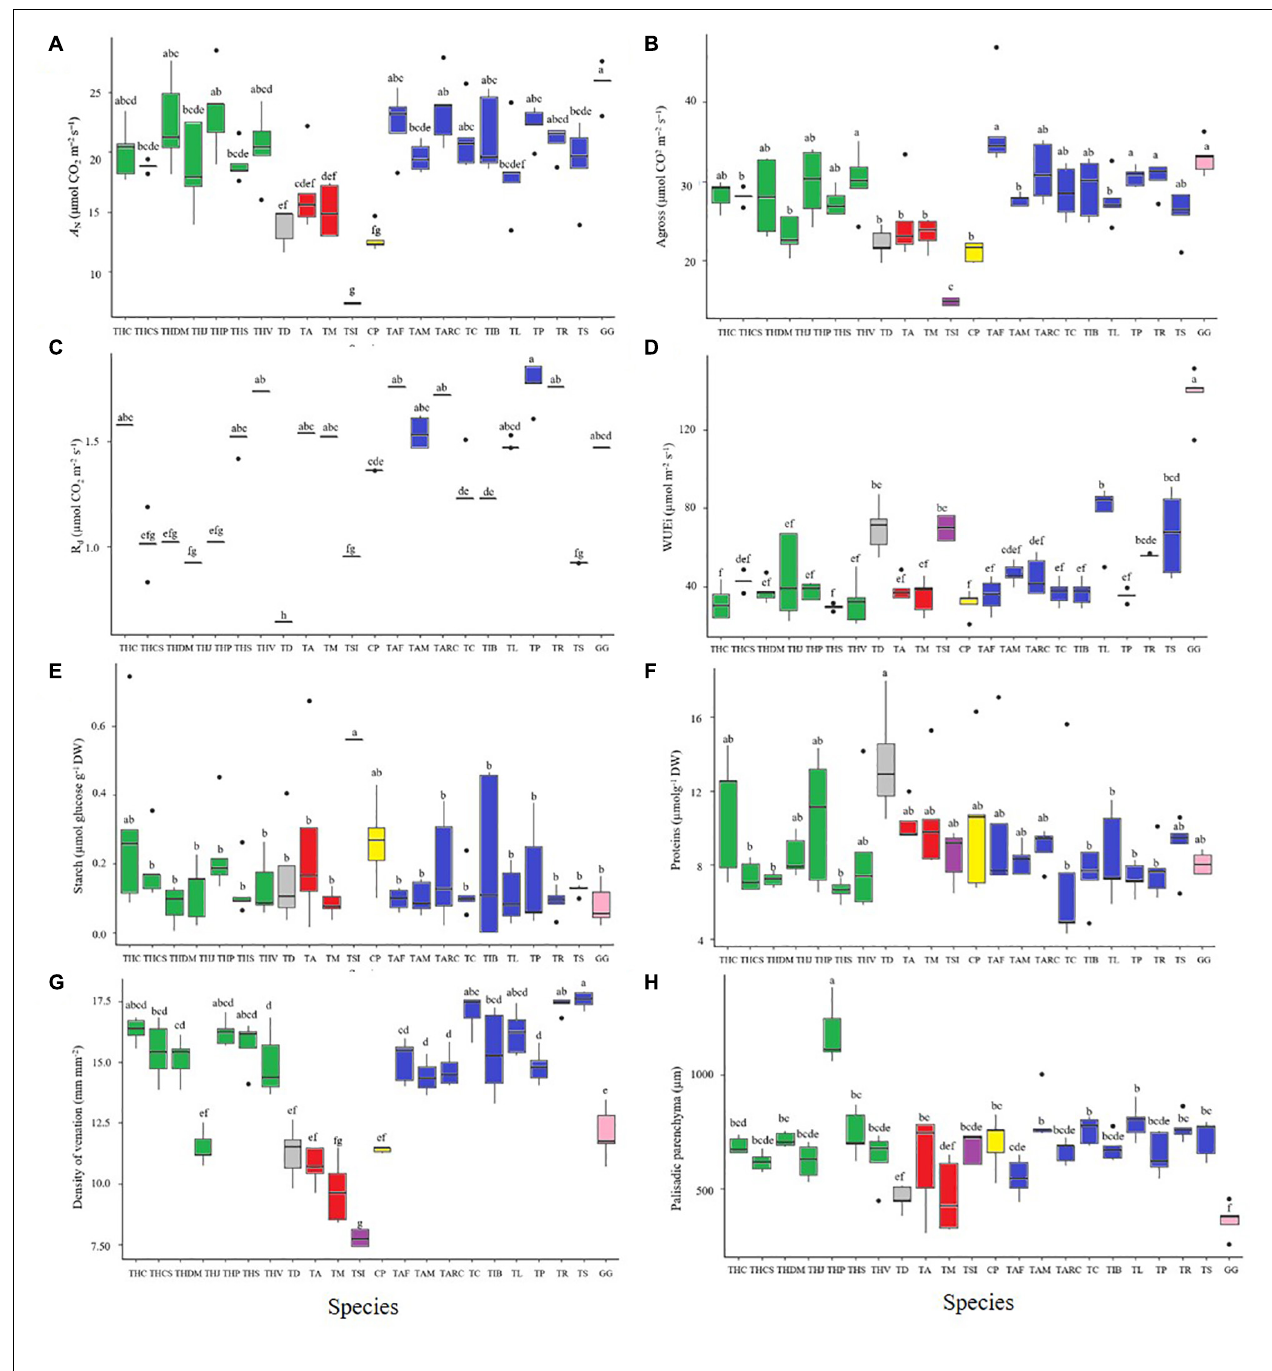
FIGURE 3 | Gas exchange and chlorophyll a fluorescence parameters in Cleomaceae species. Physiological variables: (A) Ambient CO 2 assimilation rates ( A N ) (400 ppm atmospheric [CO 2 ]). (B) Stomatal conductance ( g s ). (C) Dark respiration ( R d ). (D) Intrinsic water use efficiency (WUEi). Metabolic variables: (E) Starch content. (F) Protein content. Anatomical variable: (G) Density of venation. (H) Palisade parenchyma. Letters above individual box-scatter indicate significant groupings according to Tukey’s Test ( n = 5). The median is indicated by solid lines in each box; data dispersion is represented by the interquartile range, followed by standard error and outliers. The colored bars as well as the species acronyms are related to the groups observed in Figures 1 , 2